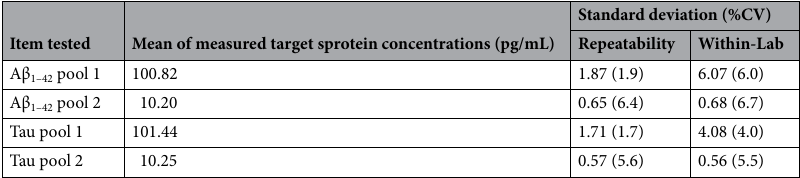
Table 1. The mean, repeatability coefficient of variation (%CV), within-lab %CV and lowest limit of quantification (LLOQ) of Aβ 1–42 and T-Tau IMR